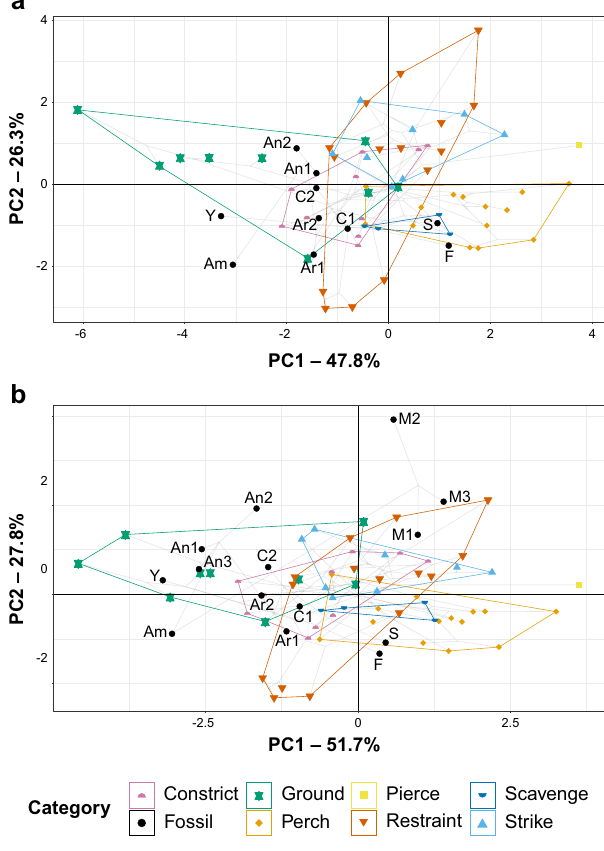
Fig.7|PCAphylomorphospaceofmodernavianandearlytheropod fl yerclaws, basedontraditionalmorphometrics,groupedbyecologicalcategory. Datasets a include and b exclude measurements of digit I, as most of the fossil paravians in this study do not preserve digit I. In both graphs, claw curvature increases across PC1 and claw size relative to digit III increases across PC2. See Fig. 8 for precise character loadings. Taxon abbreviations: Am Ambopteryx IVPP V24192, An1 Anchiornis STM 0-1, An2 Anchiornis STM 0-114, An3 Anchiornis STM 0-147, Ar1 Archaeopteryx MB.Av.101,Ar2 Archaeopteryx WDC-CSG-100,C1 Confuciusornis IVPP V13156, C2 Confuciusornis STM 13-55, F Fortunguavis IVPP V24192, M1